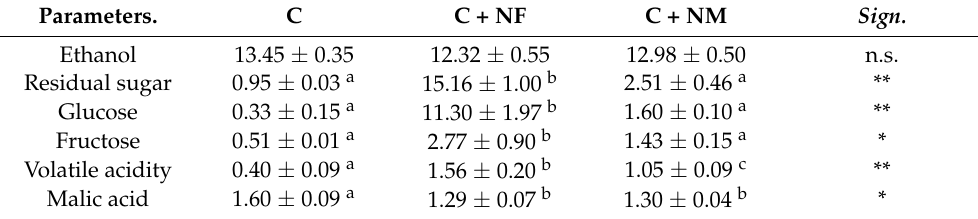
Table 1. Main oenological parameters analyzed in wines obtained by the mixed starters with S. cerevisiae EC1118 (C) and H. osmophila (ND1) as free (NF) and microencapsulated (NM) cells in comparison to the single starter wine with EC1118 (C). The ethanol was expressed as v / v %, while the other parameters were expressed as g/L. For each compound, different superscript letters mean sig- nificant differences at p < 0.05 (*) and 0.001 (**) among the wines produced in the different conditions. n.s.: not significant. Data are expressed as mean value ± SD of three independent experiments. Parameters. C C + NF C + NM